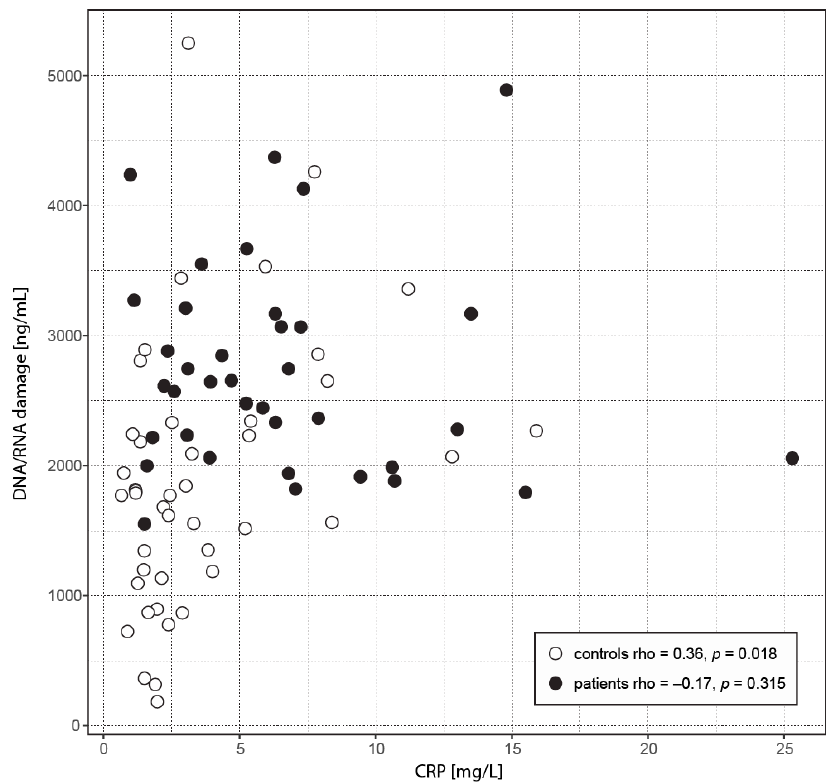
Figure 3. The relationship between CRP and DNA/RNA damage. The scatterplot depicts a relationship between CRP and DNA/RNA damage. Data of patients shows a significant shift toward higher values compared to controls (see Figures 1 and 2) and also a different relationship (Fisher p = 0.0237). While in controls the correlation is positive, the relationship found in patients was not significantly different from zero.